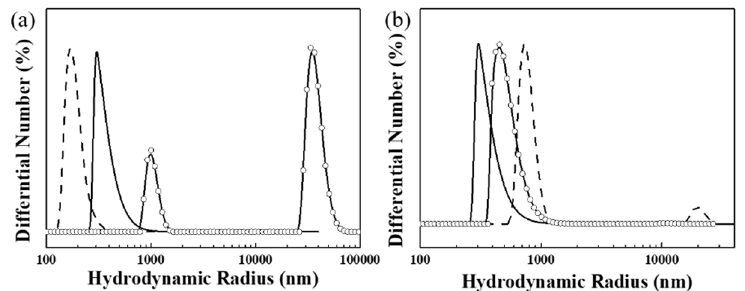
Figure 1. Hydrodynamic radius of formalin- killed cells (FKC) (solid line), clays (dashed line), and FKC + clay mixture (circle and line) with respect to ( a ) layered double hydroxide (LDH) and ( b ) kaolinite (KA).